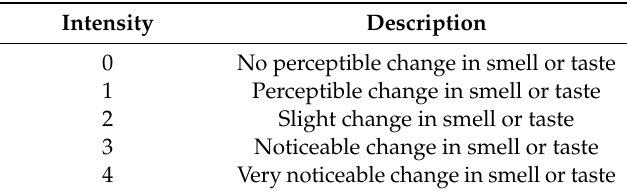
Table 3. Rating scale according to DIN 10,955 used for the intensity of the di ff erence in odor and taste compared to the